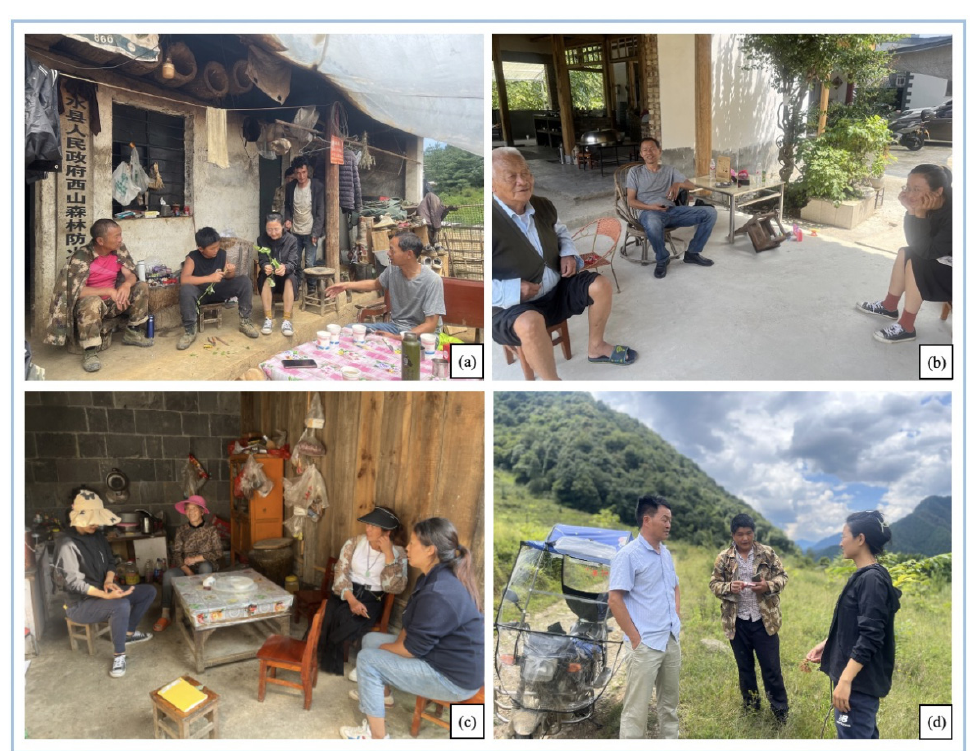
Figure 2. Ethnobiological surveys of Gaoligongshan pigs. ( a – c ) Semi-structured interviews in different households; ( d ) participatory observation in the field. (Photo by Xingcen Zhao, August 2022, Photographed separately in Laowo, Ronghua, Yuanxi and Chongren villages).